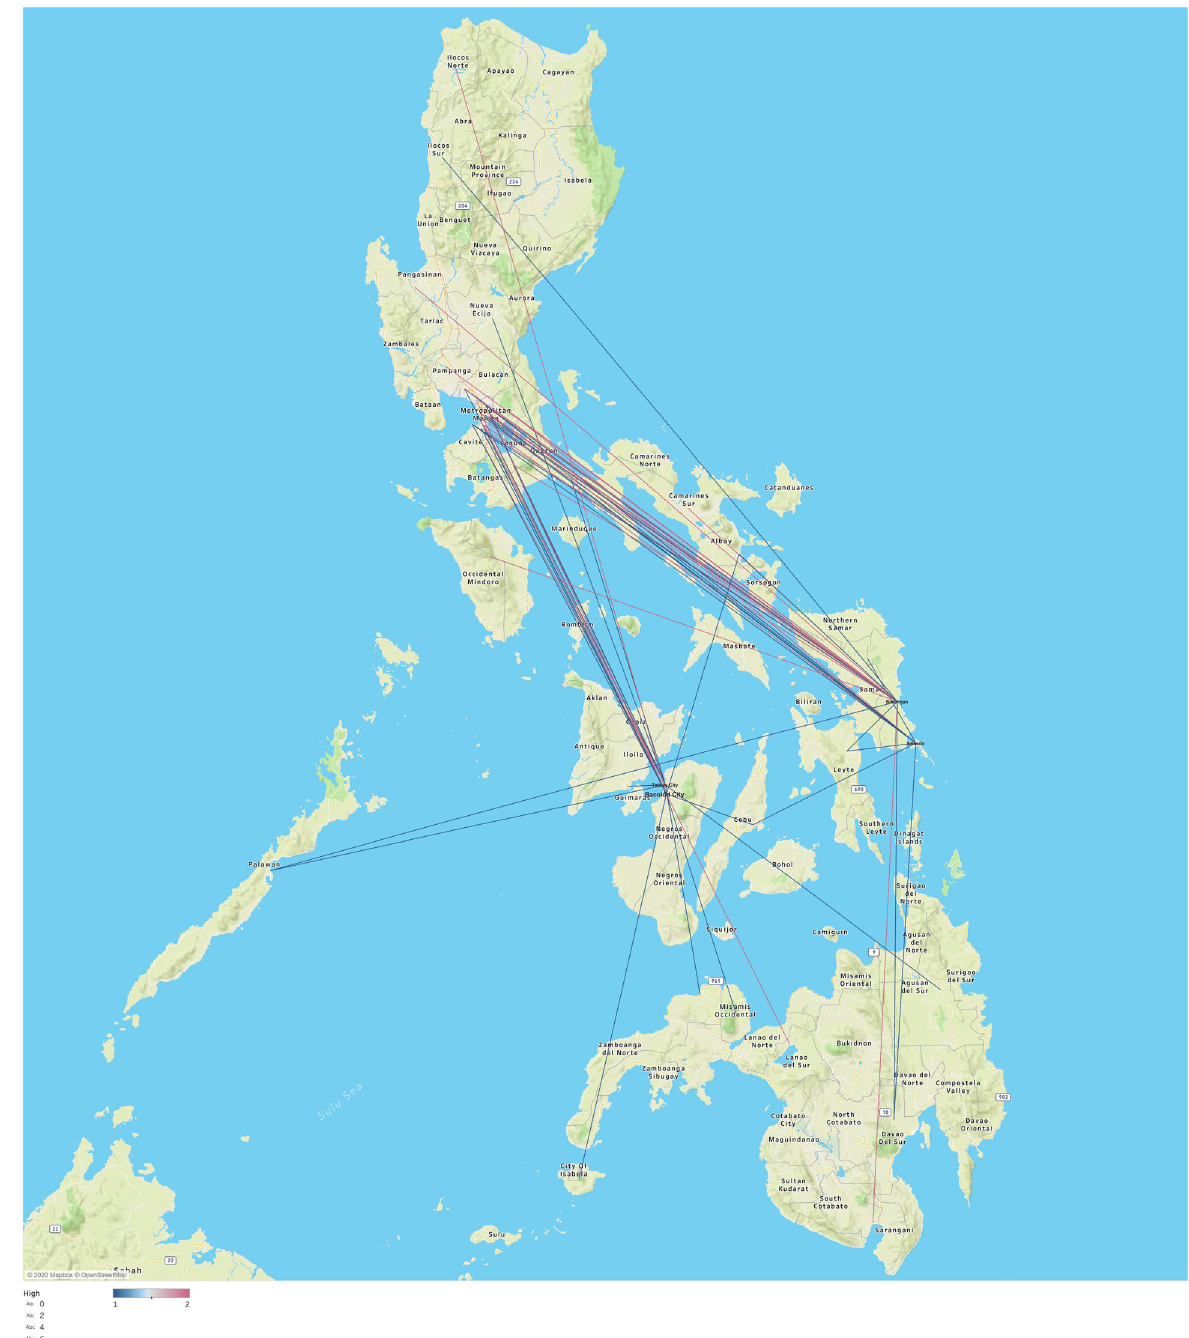
Fig. 4 Overview of internal migration movements from the Visayas. Internal migration fl ows generated from the study sites in the Visayas (blue lines indicate male movements and red lines female